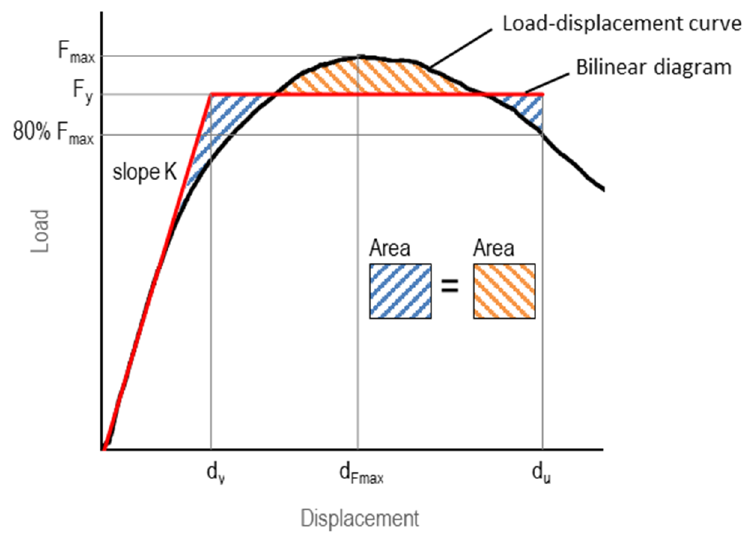
Figure 12. Method to obtain the bilinear diagram.